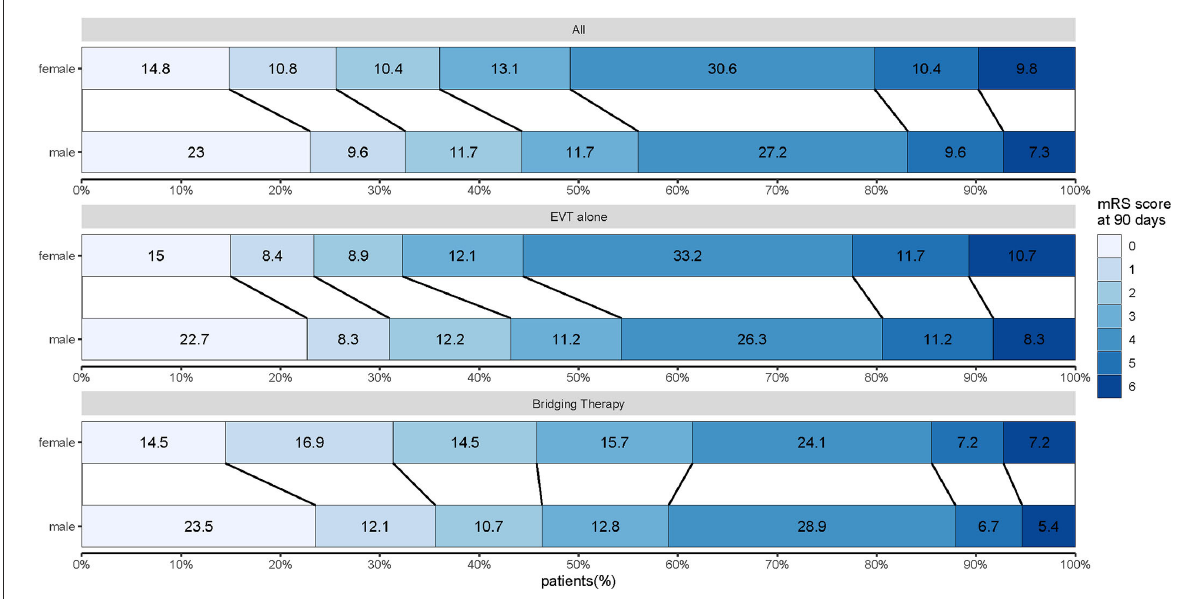
FIGURE2 Distribution of modified Rankin scale scores at 90 days for women and men treated with EVT alone and bridging therapy. Scores range from 0 to 6, with 0 indicating no symptoms, 1 indicating no clinically significant disability, 2 indicating slight disability (patient can function without assistance but cannot carry out all previous activities), 3 indicating moderate disability (patient requires some help but can walk unassisted), 4 indicating moderately severe disability (patient cannot attend to bodily needs without assistance and cannot walk unassisted), 5 indicating severe disability (patient requires constant nursing care and attention), and 6 indicating